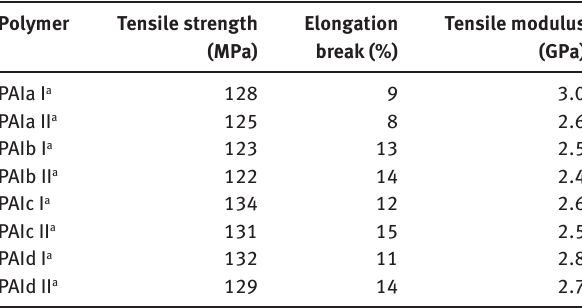
Table 4: The mechanical properties of polyamide-imides synthe- sized by two